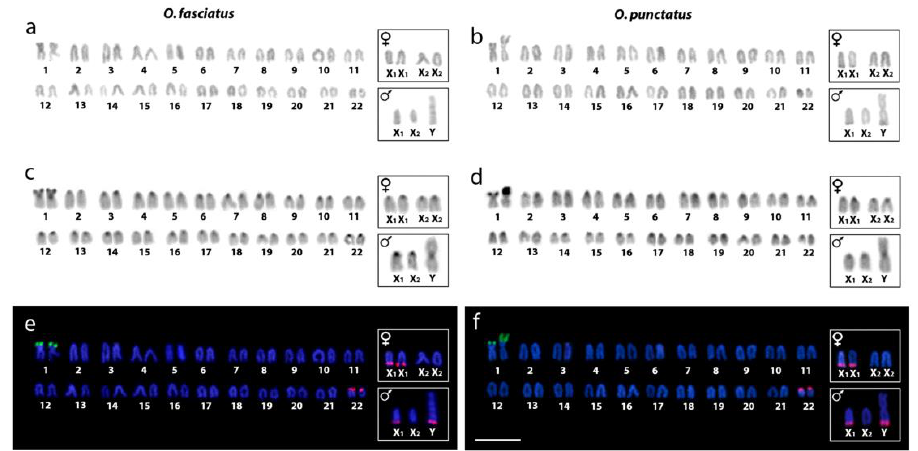
Figure 1. Karyotypes of males and females of O . fasciatus ( a , c , and e ) and O . punctatus ( b , d , and f ) after different cytogenetic protocols. Giemsa staining ( a and b ); C-banding ( c and d ), and dual-color fluorescence hybridization (FISH) with 18S (green) and 5S (red) rDNA probes ( e and f ). Chromosomes were counterstained with 4′,6-diamidino-2-phenolindole (DAPI; blue). Insets depict 4 (cid:48) ,6-diamidino-2-phenolindole (DAPI; blue). Insets depict male and female sex chromosomes. Scale male and female sex chromosomes. Scale bar = 5 μm. bar = 5 µ